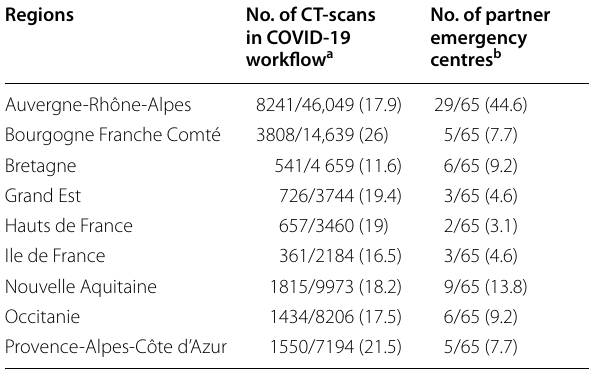
Table 1 Characteristics of the teleradiological cohort per